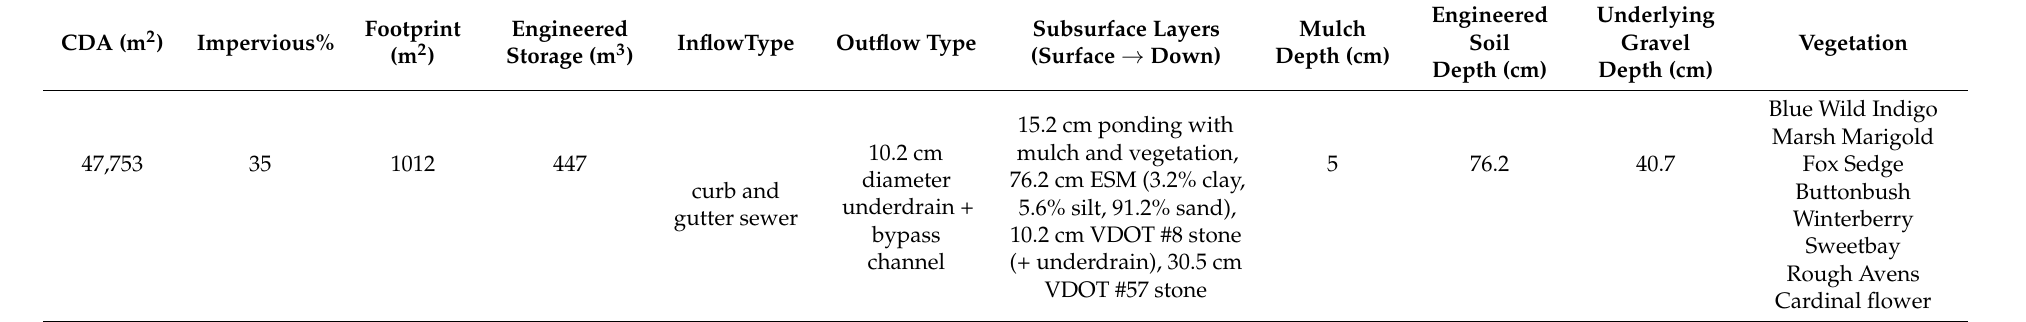
Table 1. Design specifications and other characteristics for monitored BR (CDA: contributing drainage area; ESM: engineered soil